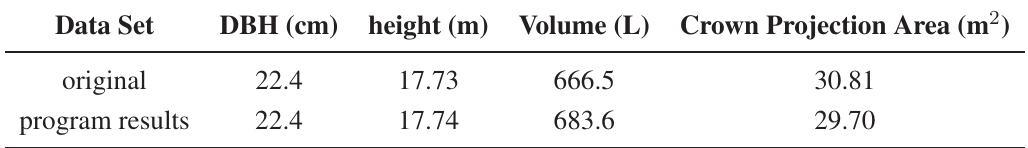
Table 6. Comparison between original data and the proposed method results for the artificial point cloud.